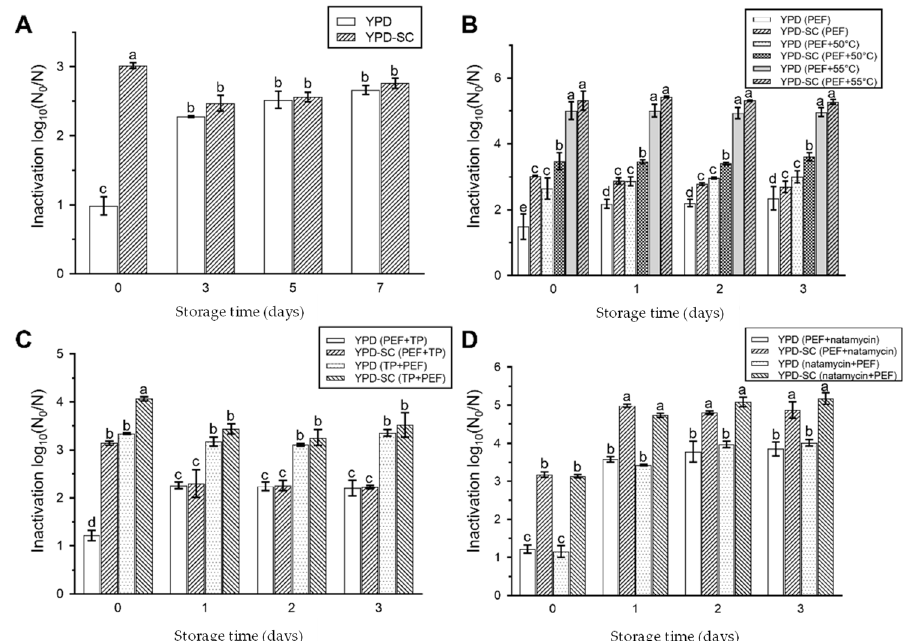
Figure 4. Inactivation of S. cerevisiae in cantaloupe juice by combining PEF with temperature or natural preservatives. The synergistic effects of PEF combined with low temperature (4 ◦ C) ( A ), mild temperature (50 and 55 ◦ C) ( B ), tea polyphenols ( C ) and natamycin ( D ) on the inactivation of S. cerevisiae cells in cantaloupe juice. Data are expressed as mean ± standard deviation. Significant differences are indicated by different letters ( p <